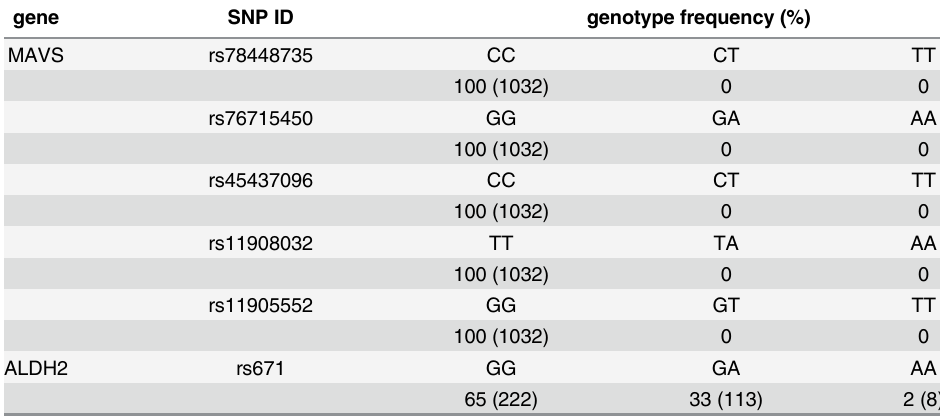
(Table 7), similar to published data in the NCBI database (http://www.ncbi.nlm.nih.gov/ projects/SNP/snp_ref.cgi?rs=671). This result showed that there was no issue regarding the Table 7. Genotype frequencies detected in this